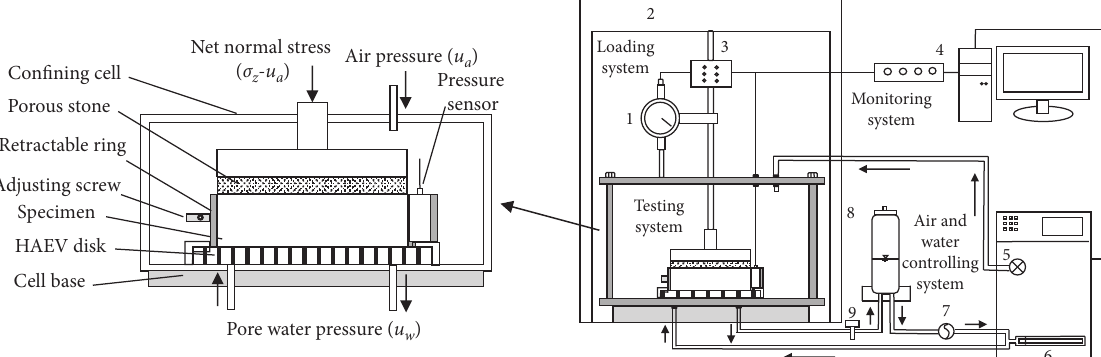
Figure 1: Schematic view of the UC oedometer: (1) vertical digital displacement gauge, (2) reaction frame, (3) pressure transducer, (4) data logger, (5) air pump, (6) water pump, (7) solenoid valve, (8) bubble flushing cell, and (9) stop-flow valve.